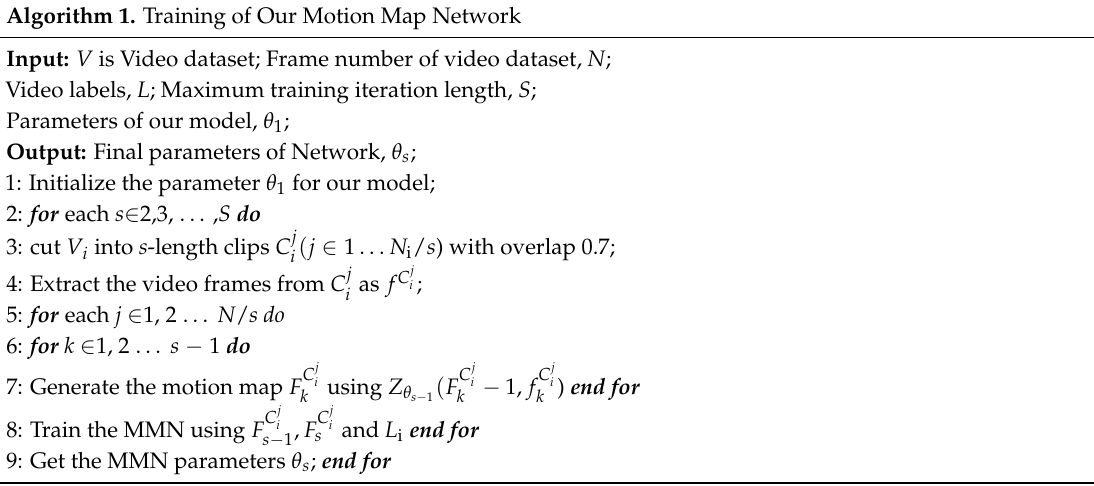
Algorithm 1. Training of Our Motion Map